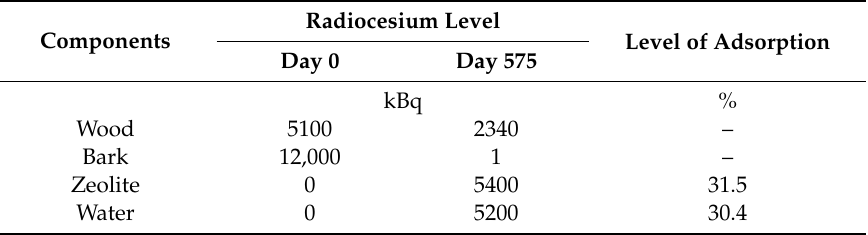
Table 1. Distribution of radiocesium in water and zeolite based on balance between elution and adsorption of radiocesium during